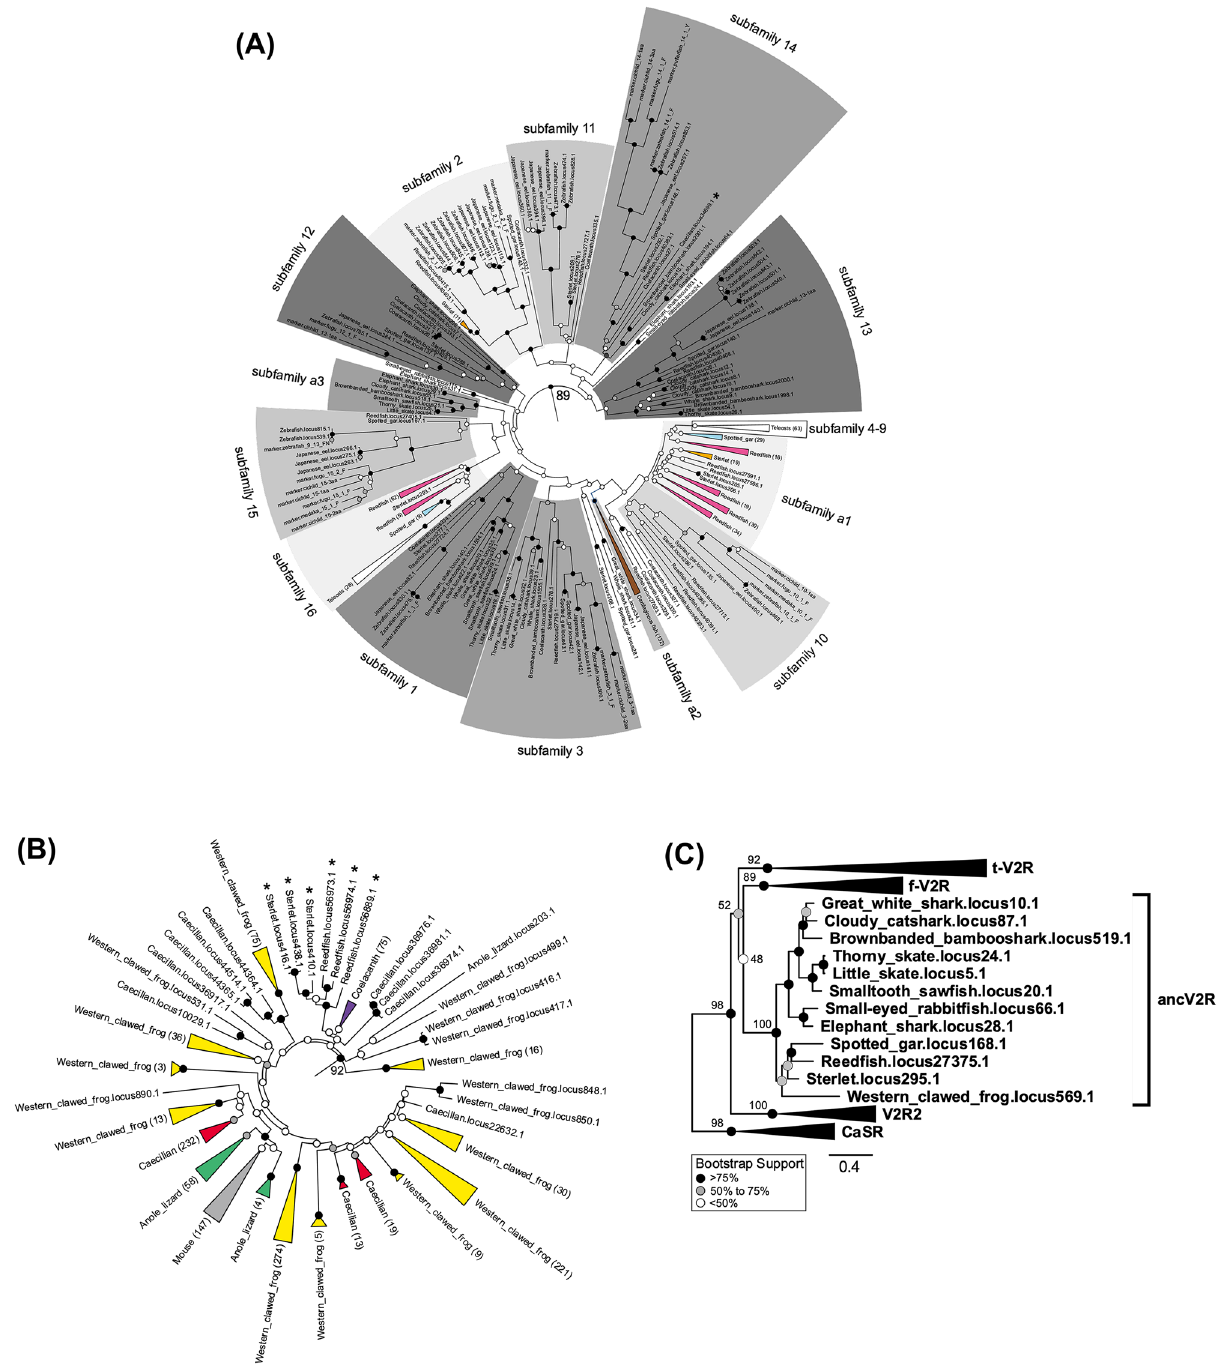
Figure 1. Phylogenetic relationships of V2R s of a broad range of vertebrates from cartilaginous fish to tetrapods constructed using RAxML-NG v.1.0.1 (https:// github. com/ amkoz lov/ raxml- ng). ( A ) Phylogenetic tree of f- V2R s. Note that f- V2R s were subdivided into 16 known and 3 novel subfamilies, as indicated by gray thick bars. Triangles in red, orange, blue, white, and brown indicate the expanded V2R clusters specific to reedfish, sterlet, spotted gar, cartilaginous fish, and teleost fish, respectively. Only one f- V2R s found in the caecilian species was marked using an asterisk. ( B ) Phylogenetic tree of t- V2R s. Triangles in violet, pink, yellow, green, and gray indicate expanded V2R clusters specific to coelacanth, caecilian, western clawed frog, anole lizard, and mouse, respectively. Asterisks were used to mark the t- V2R s identified in reedfish and sterlet. Note that the t- V2R s, in contrast to the f- V2R s, are composed of many clusters that are expanded in a species-specific manner. ( C ) Overview of the phylogenetic tree of all V2R s showing novel orthologous clade ancV2R . The calcium-sensing receptor ( CaSR ) gene was used for outgrouping all V2R s. The OTU names consist of the common name and locus as summarized in Supplementary Table S1. The f- V2R s, t- V2R s, and V2R2 clades were compressed into black triangles. The number on the branches indicates the bootstrap support values for particular nodes. Note that the grouping of the orthologous ancV2R s of cartilaginous fish, basal ray-finned fish, and western clawed frog was suggested by maximum bootstrap support (100%). The numbers next to triangles indicate the copy number of V2Rs included in the clusters. The filled circles on each node indicate bootstrap supports (black > 75, 75 ≧ gray ≧ 50, 50 > white). Scale bar indicates the number of amino acid substitutions per